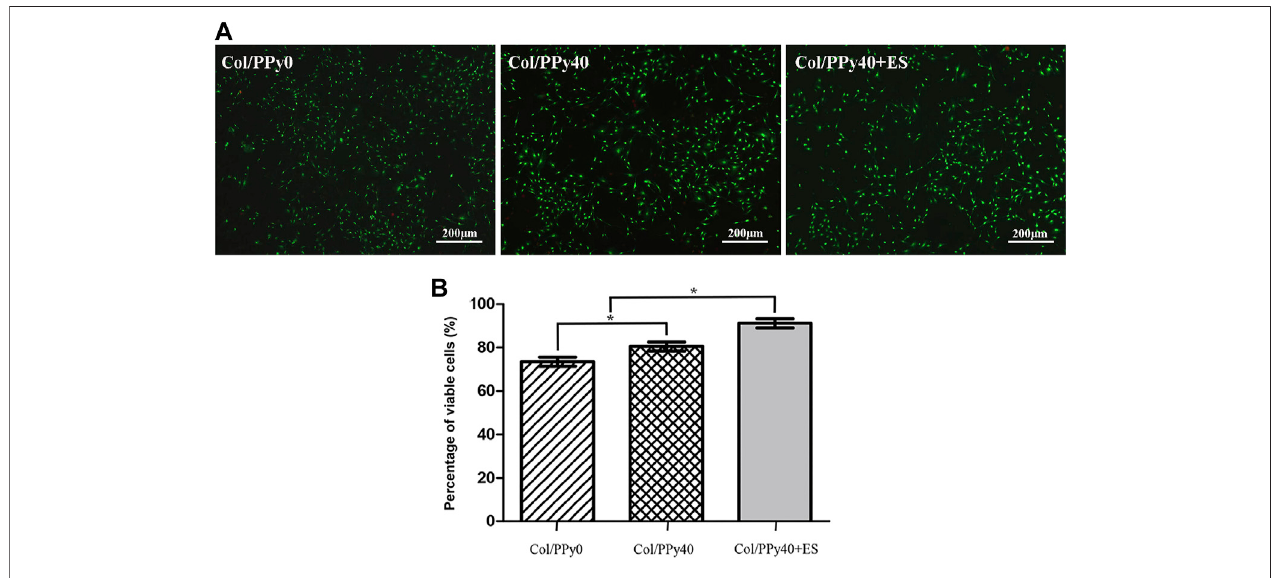
FIGURE6 |(A) Live/dead fl uorescence stainingimages ofcells differentiatedfrom NSCs in Col/PPy0, Col/PPy40, and Col/PPy40 + ES(200 mV) groups onday 3; live cells are shown in green fl uorescence and dead cells are shown in red fl uorescence; (B) Percentage of viable cells cultured in different groups on day 3.